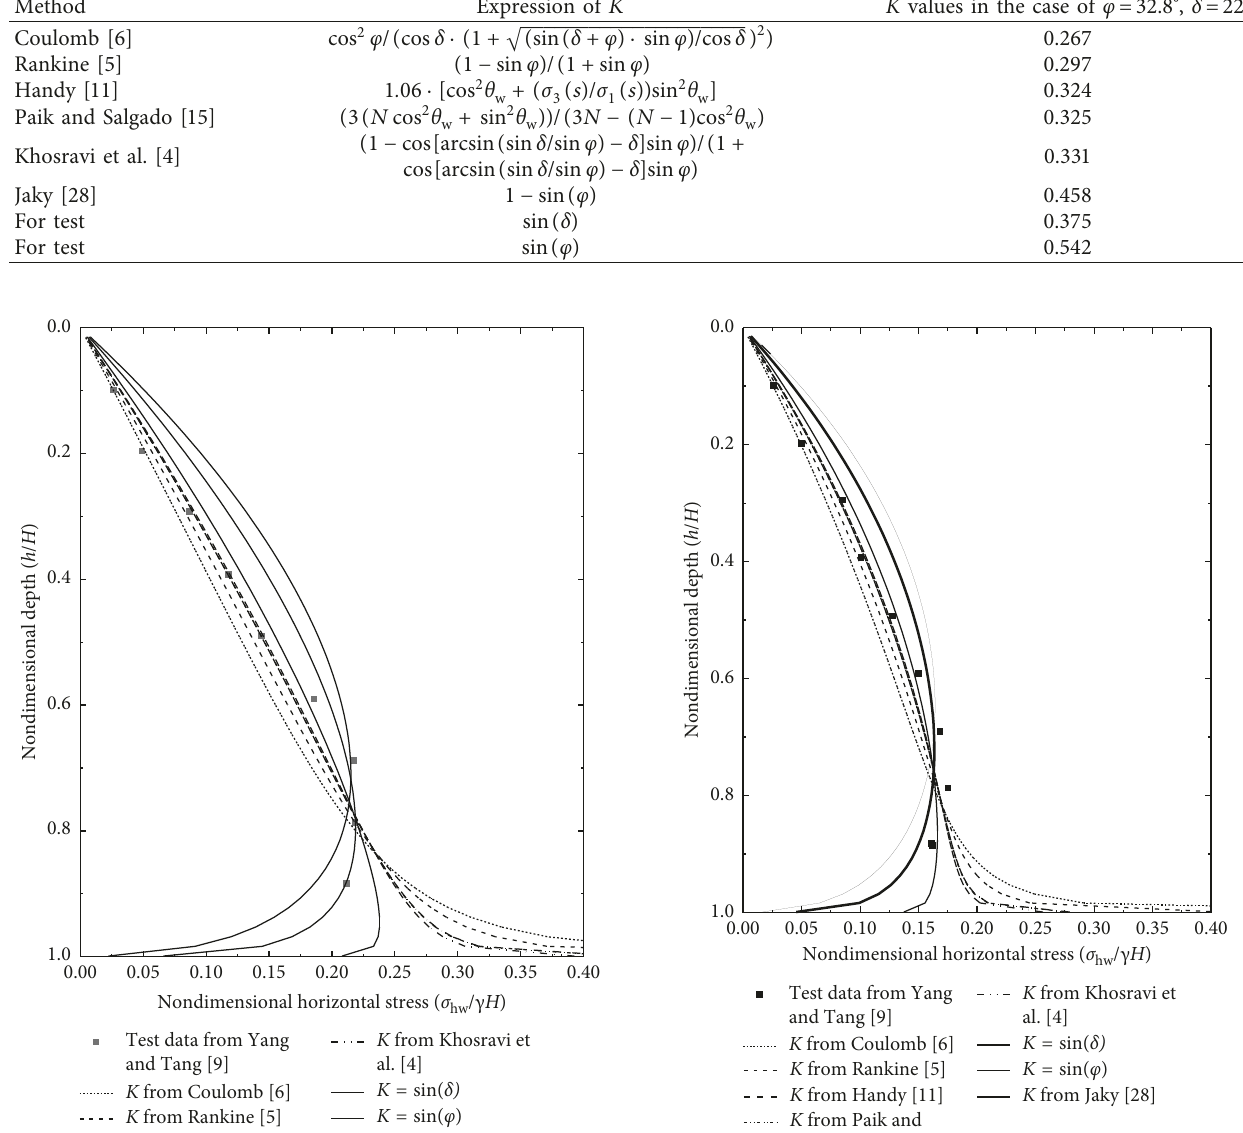
Table 4: Various K values in this paper from widely used formulas.